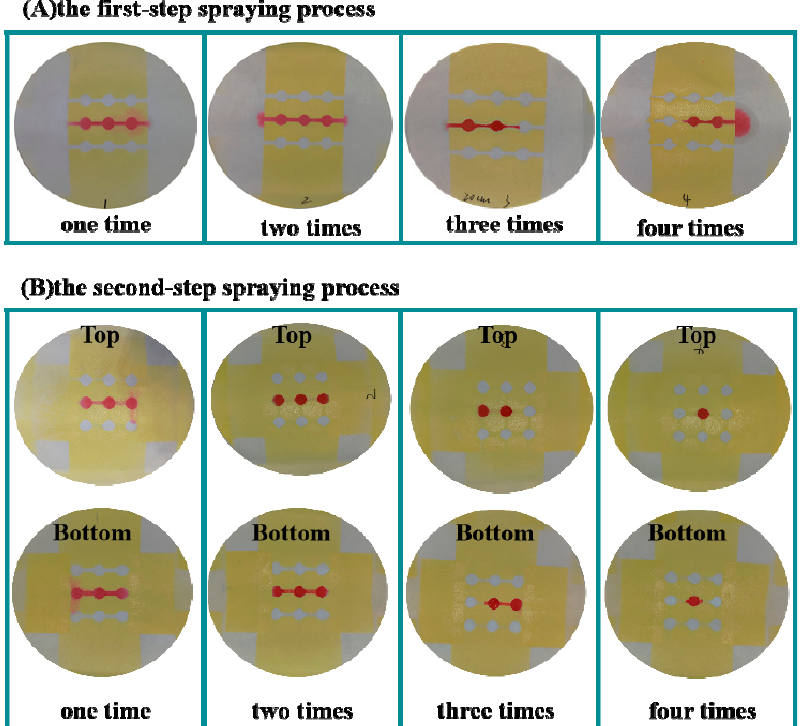
Figure 2. Optimization of the times for pressing the spray nozzle for the spraying process.